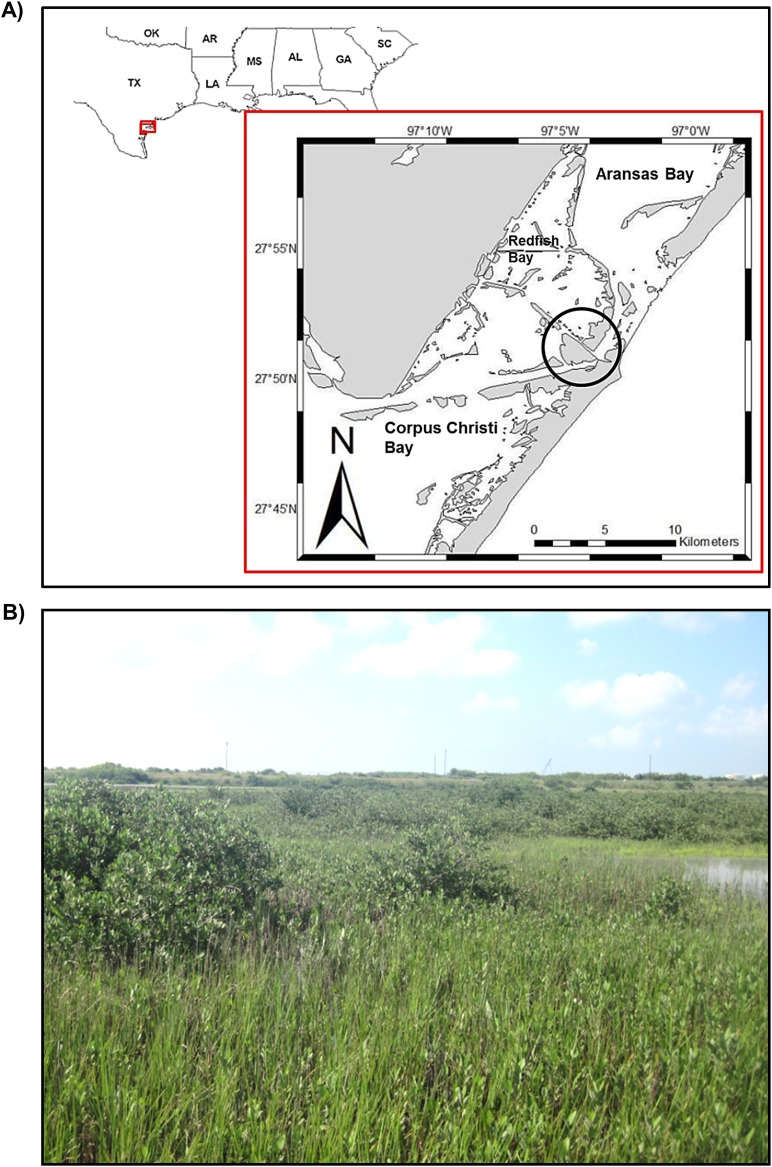
Study site location.(A) Plots were located in Port Aransas, TX, USA (B) in co-occurring Avicennia germinans (black mangrove) and Spartina alterniflora (smooth cordgrass) stands.